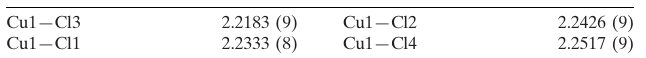
Selected bond lengths (A˚ ).